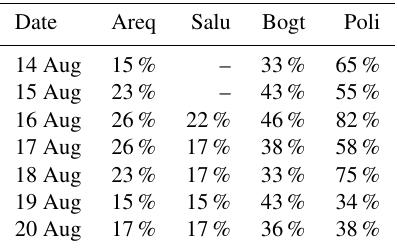
Table 2. Percent deviations (enhancements) observed in disturbed TEC compared to quiet-time reference (August event) by